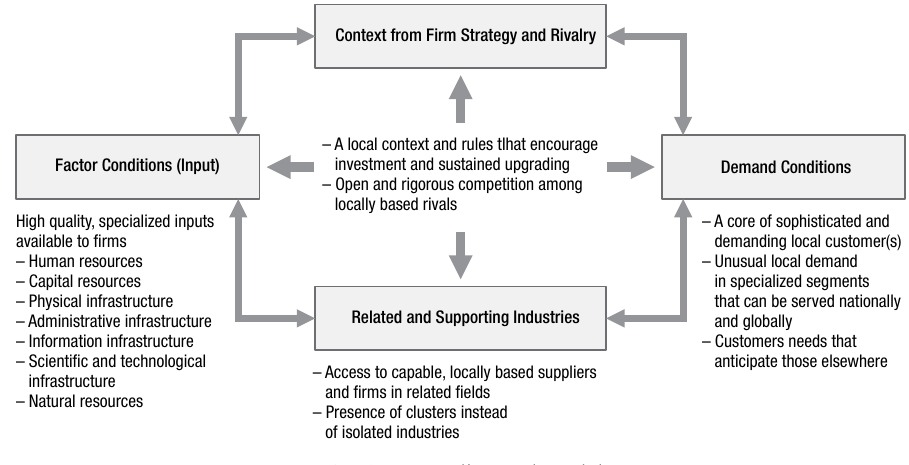
Fig. 1. Porter diamond